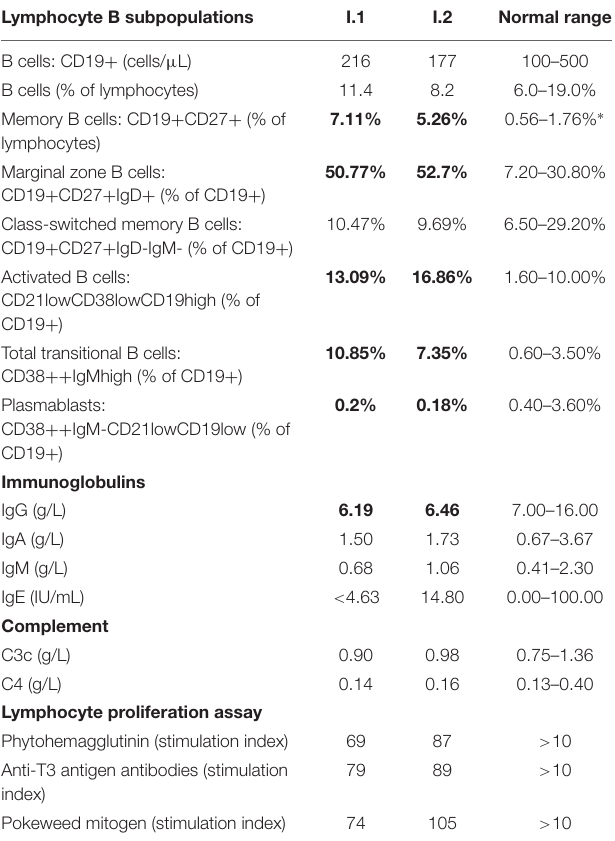
TABLE 2 | Laboratory findings in subjects with mutation in NFKB2